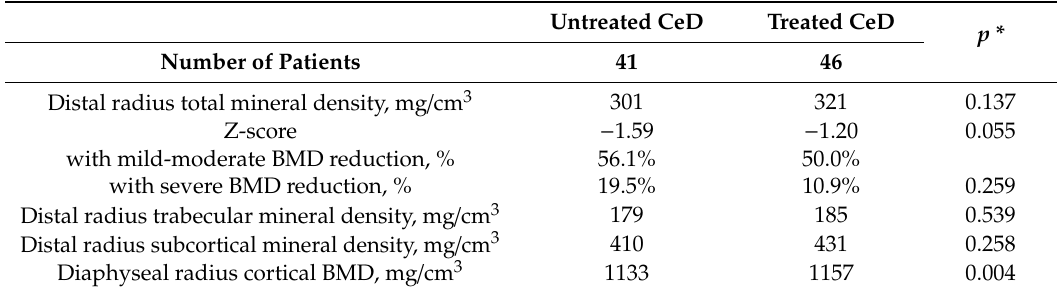
Table 5. Di ff erences in bone mineral density (BMD) between untreated CeD and treated CeD: Mean or prevalence. Untreated CeD Treated CeD p * Number of Patients 41 46